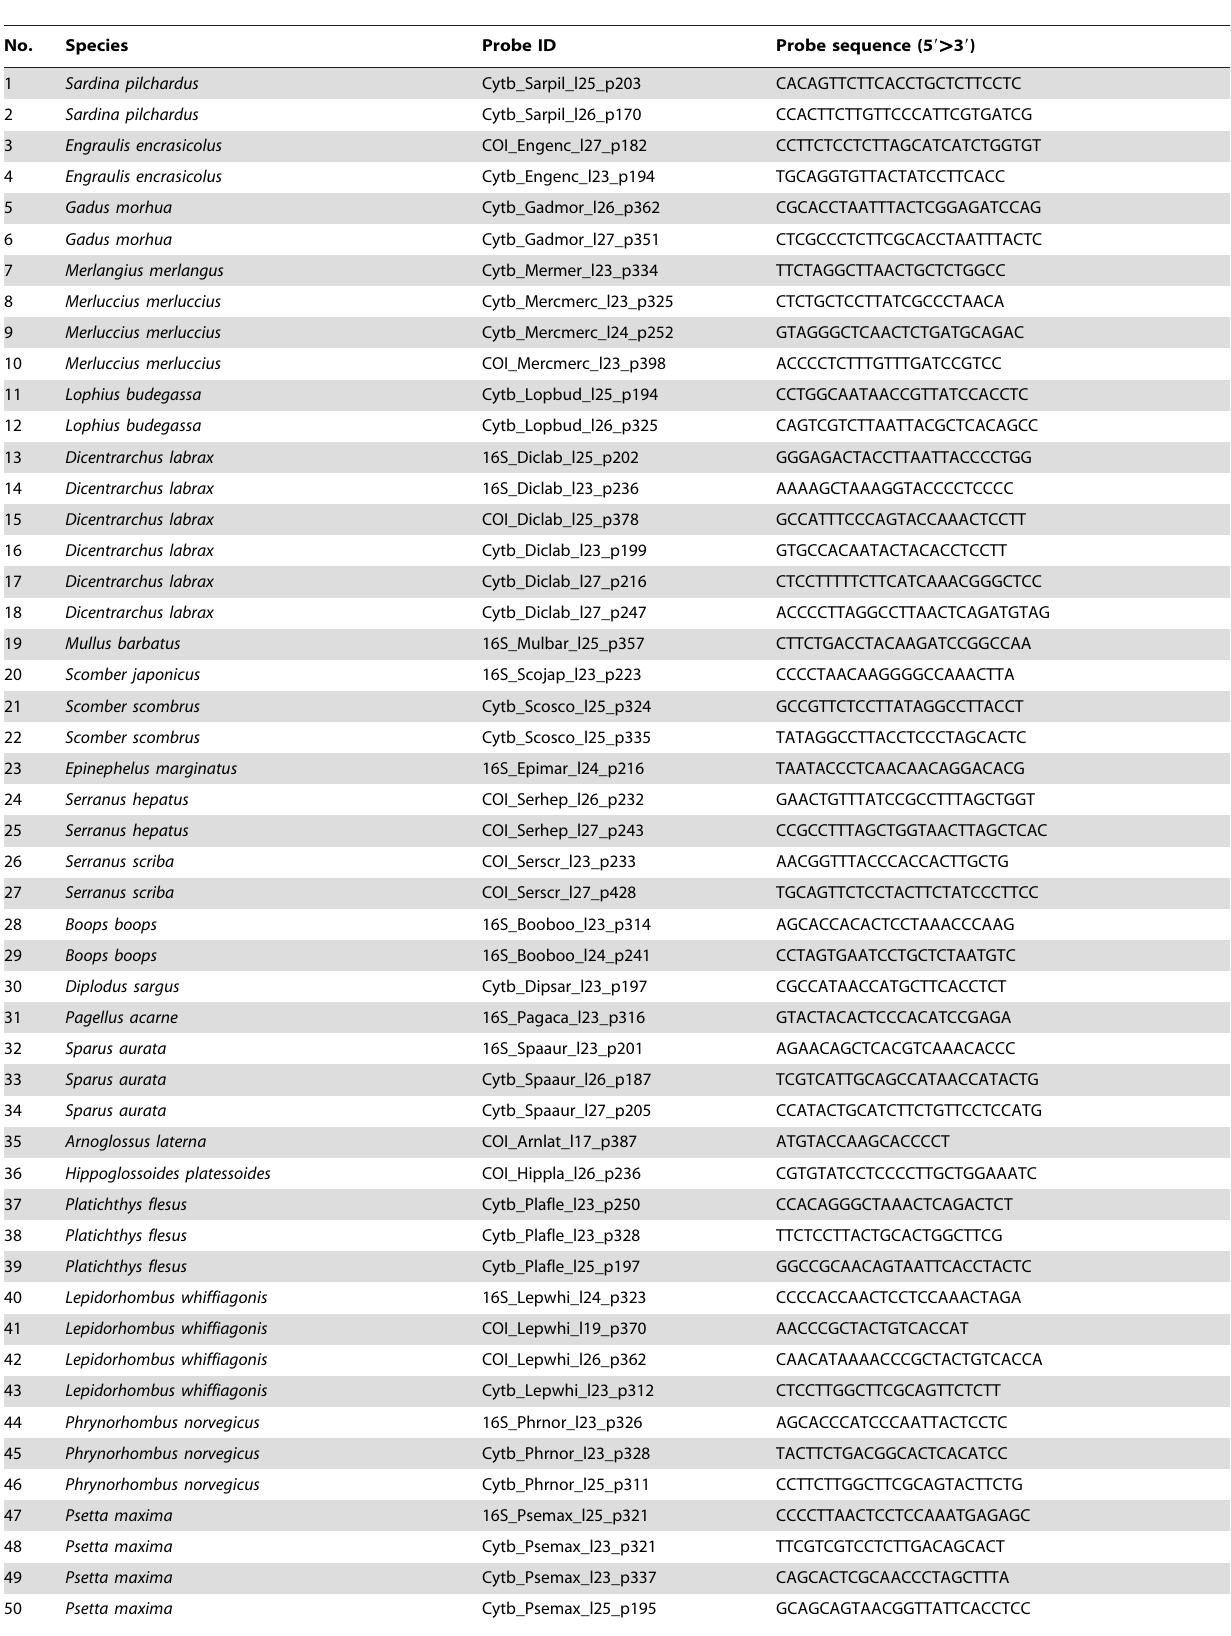
Table 3. Oligonucleotide probes for the identification of fish species from European seas.